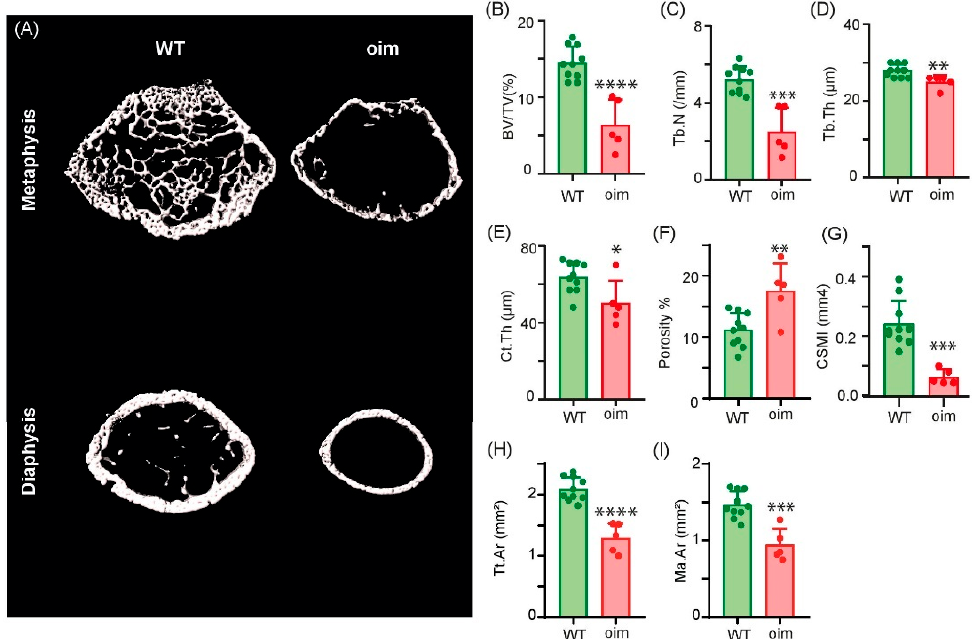
Figure 4. Three-dimensional (3D) models and micro-architecture analysis of trabecular and cortical bone in oim and WT femurs. ( A ) Three-dimensional models of bone metaphysis and diaphysis. ( B – D ) Trabecular and ( E – I ) cortical microarchitectural parameters. BV/TV = bone volume/total volume, Tb.N = trabecular number, Tb.Th = trabecular thickness, Ct.Th = cortical thickness, CSMI =